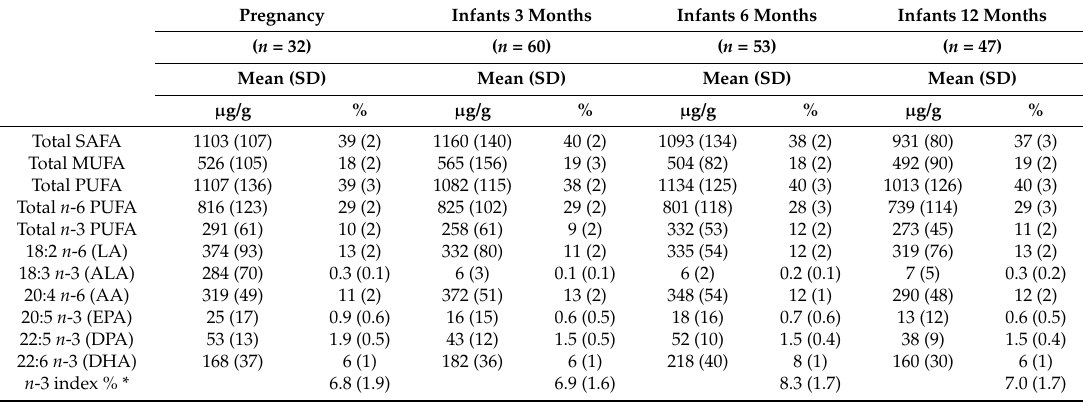
Table 2. Fatty acid composition of red blood cells ( µ g/g and %) in pregnant women in the beginning of the third trimester and infants at 3, 6, and 12 months of